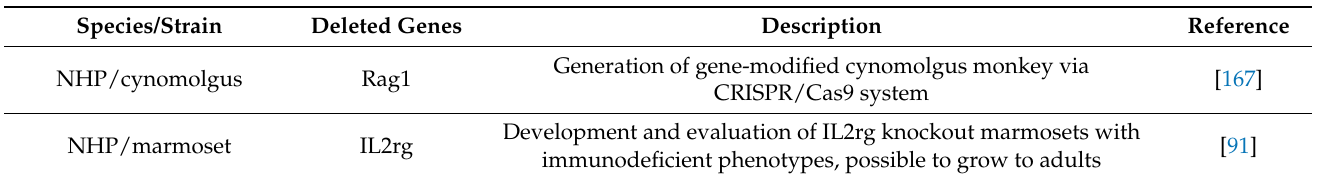
Table 5. Studies using SCID nonhuman primates (NHPs).